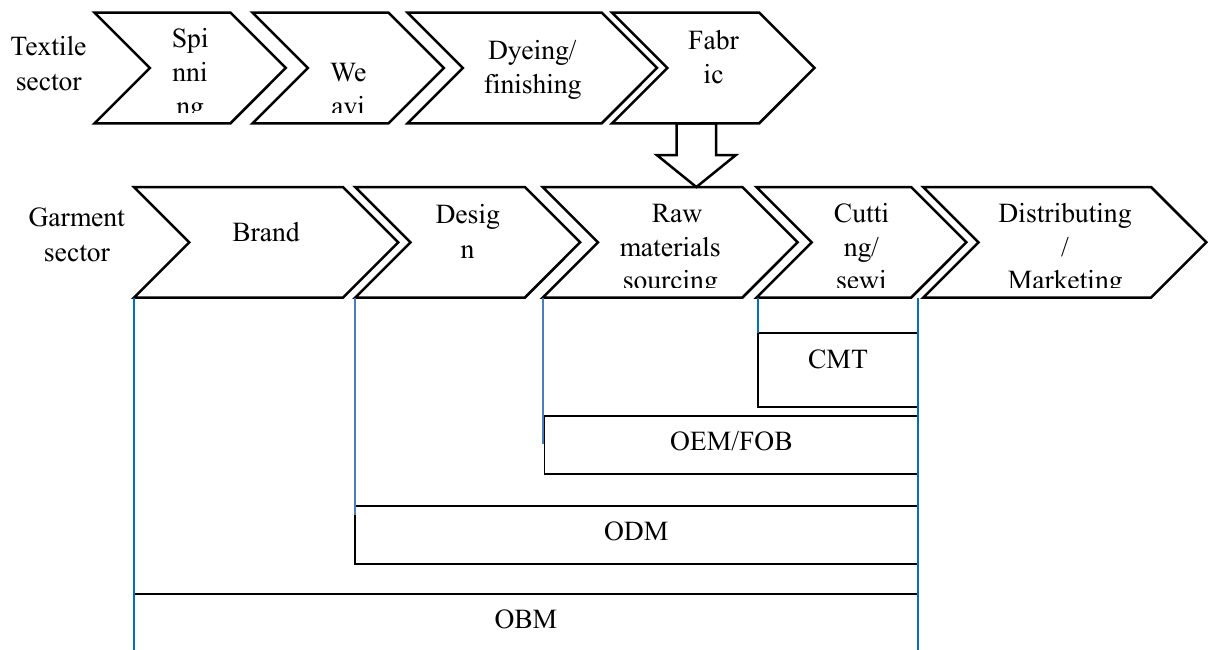
Figure 1. Main modes of production of Vietnam's textile and garment